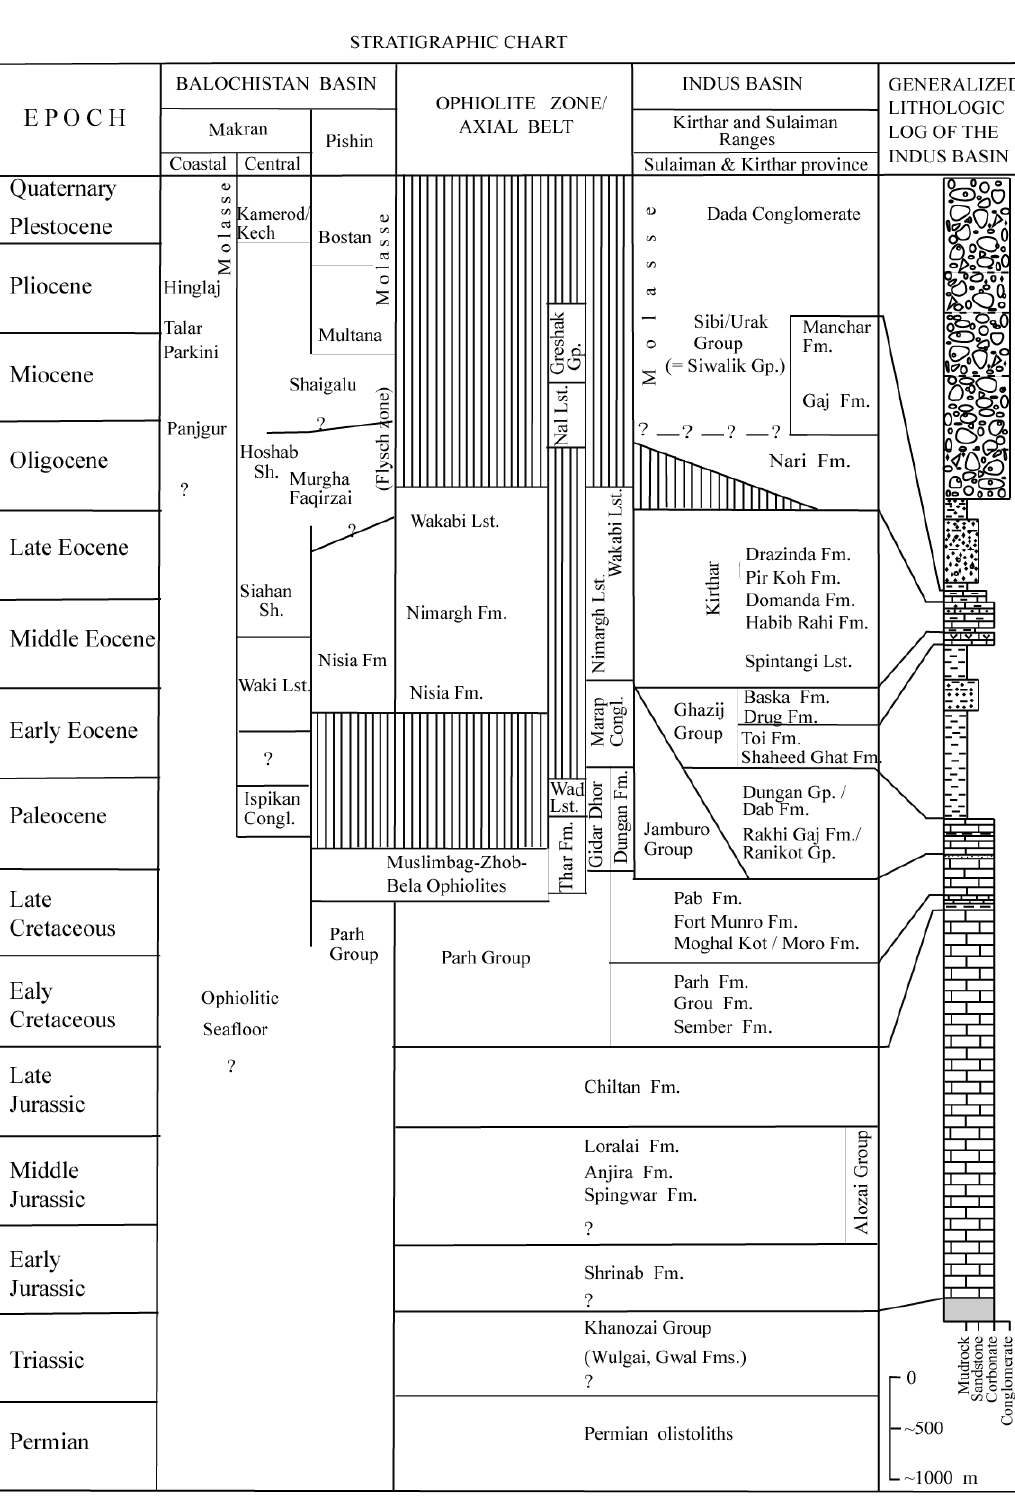
Figure 2. Simplified stratigraphy of both Indus and Balochistan Basins in Pakistan. Modified after [52,85–87]. Abbreviations: Congl., Conglomerate; Fm., Formation; Gp., Group; Lst., Limestone; Sh.,